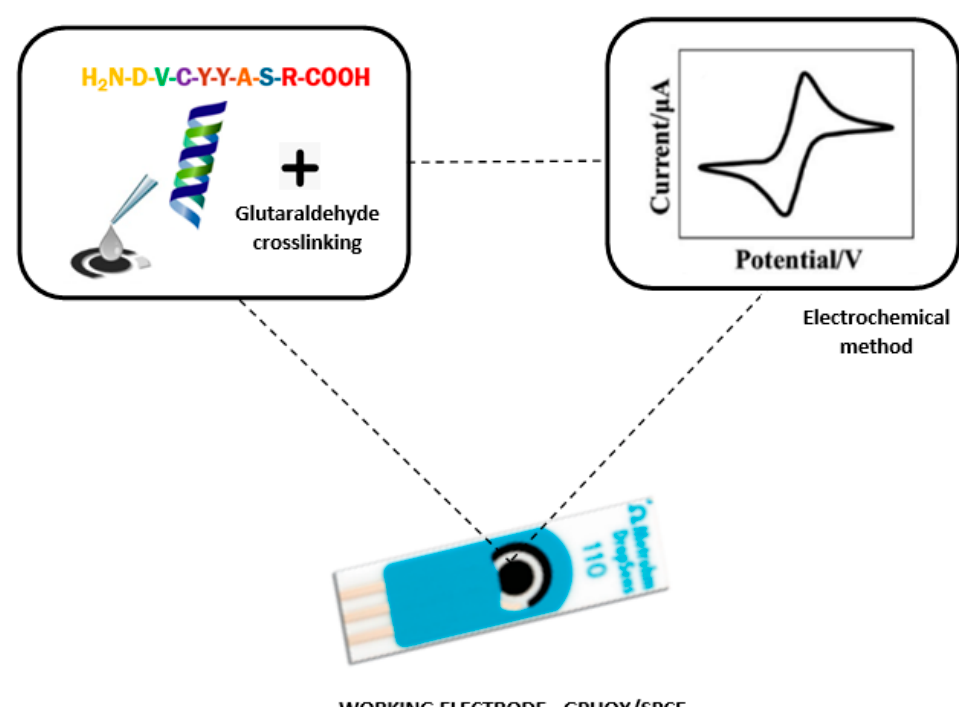
Figure 3. Preparation process of GO-Peptide/SPCE sensor .